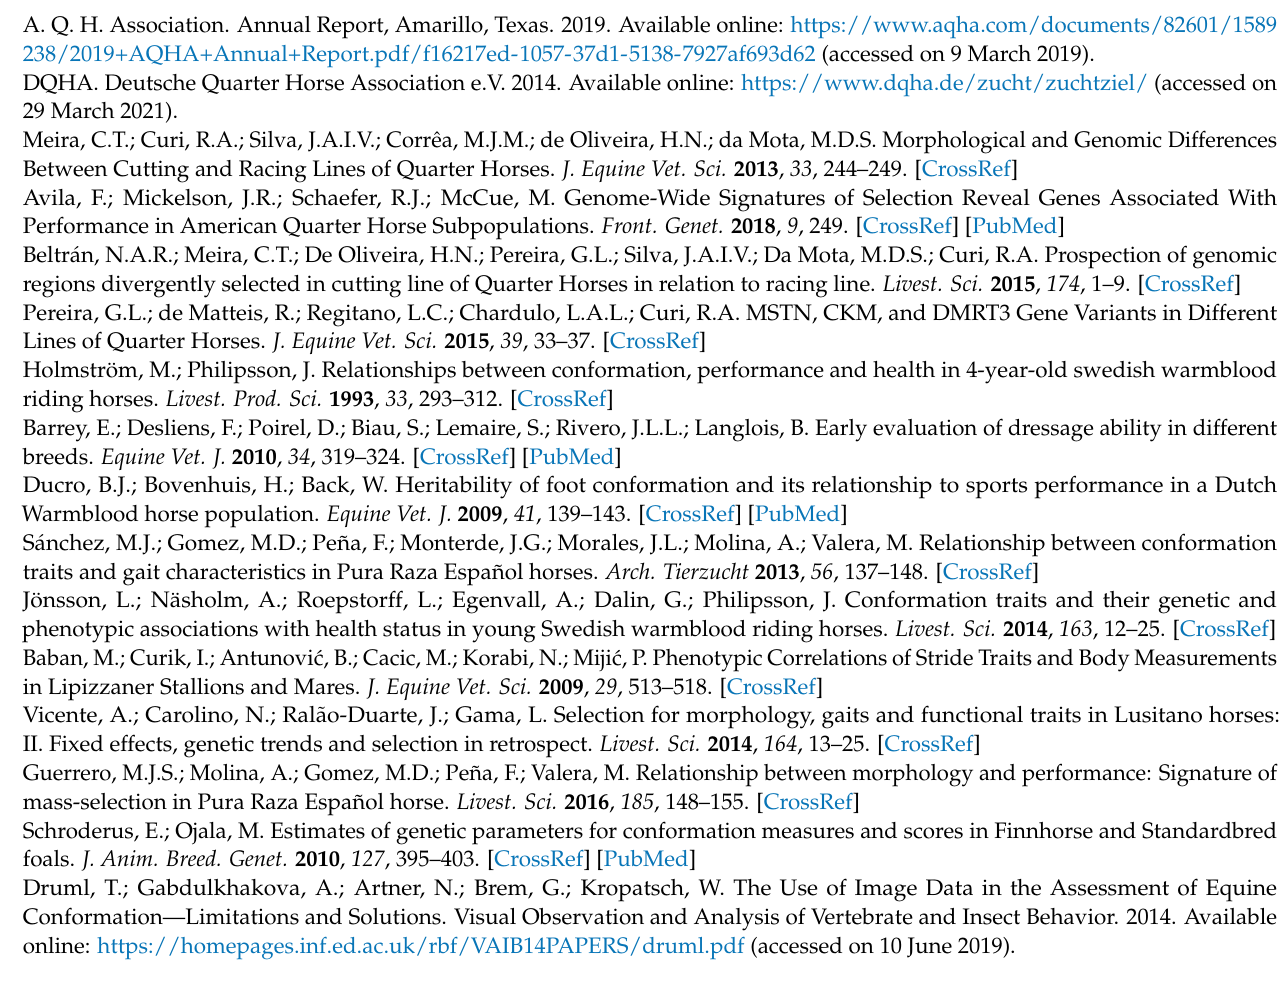
description, Table S3: Crosstable of Chi Squared Test for HaW compared to HaC. Table S4: Chi Squared Test for HaW compared to